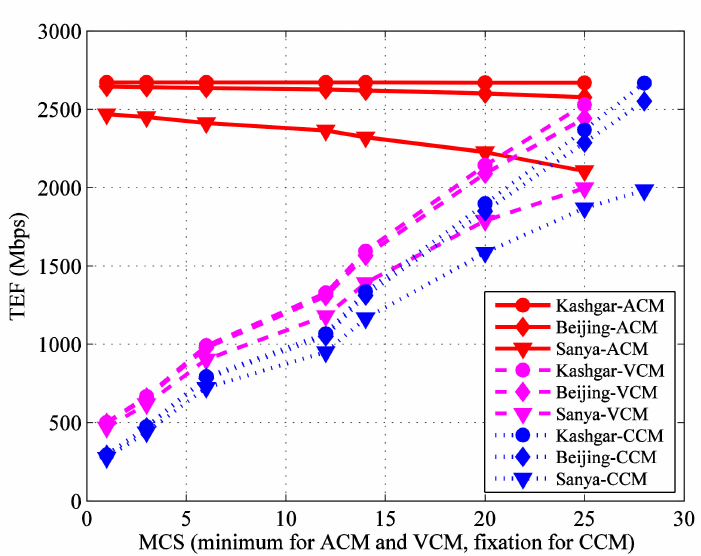
Figure 8. TEF comparison of different G/S adopting different transmission